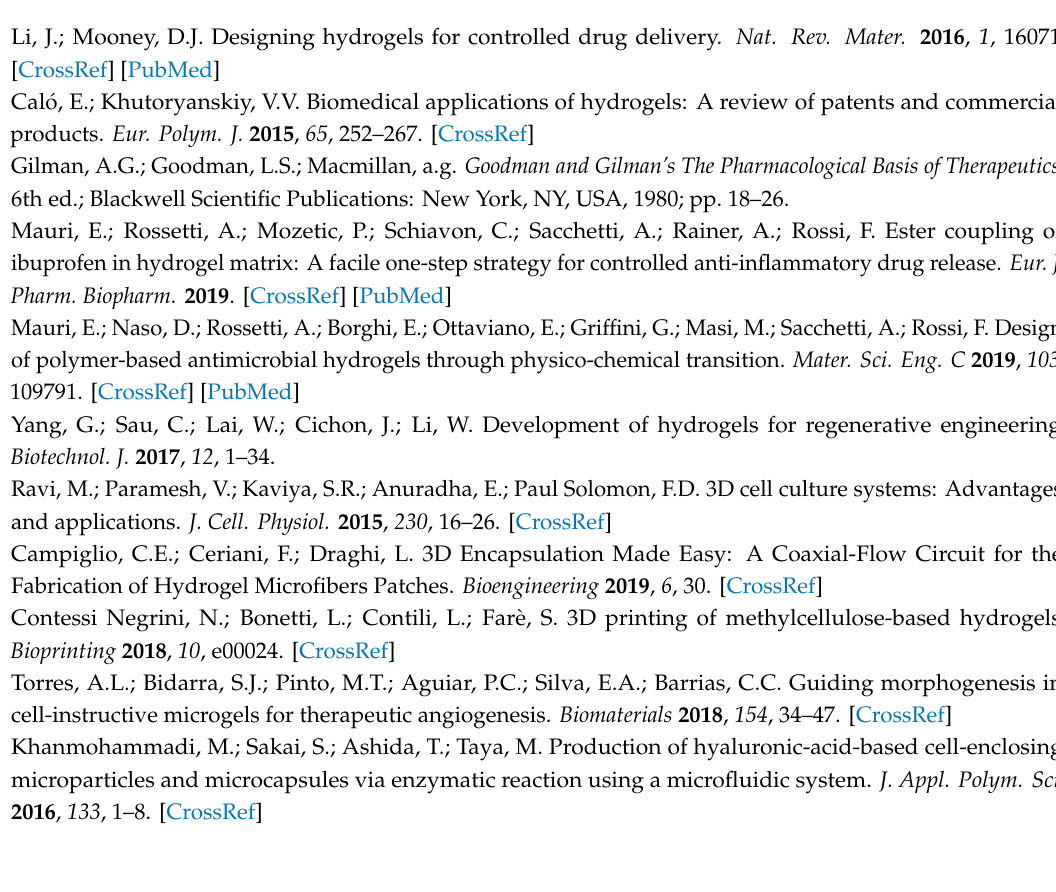
1 / 183 / s1. Figure S1: Ibuprofen chemical structure, Figure S2: Zoom of 1 H high-resolution magic angle spinning nuclear magnetic resonance (HR-MAS) spectra of: ( a ) ibuprofen (IB); ( b ) IB / β -cyclodextrin ( β -CD) (1:1) complex loaded in C1 hydrogel, Figure S3: Zoom of 1 H HR-MAS spectra of: ( a ) IB; ( b ) IB / β -CD (1:1) complex loaded in C1 hydrogel, Figure S4: Zoom of 1 H HR-MAS spectra of: ( a ) β -CD; ( b ) IB / β -CD (1:1) complex loaded in C1